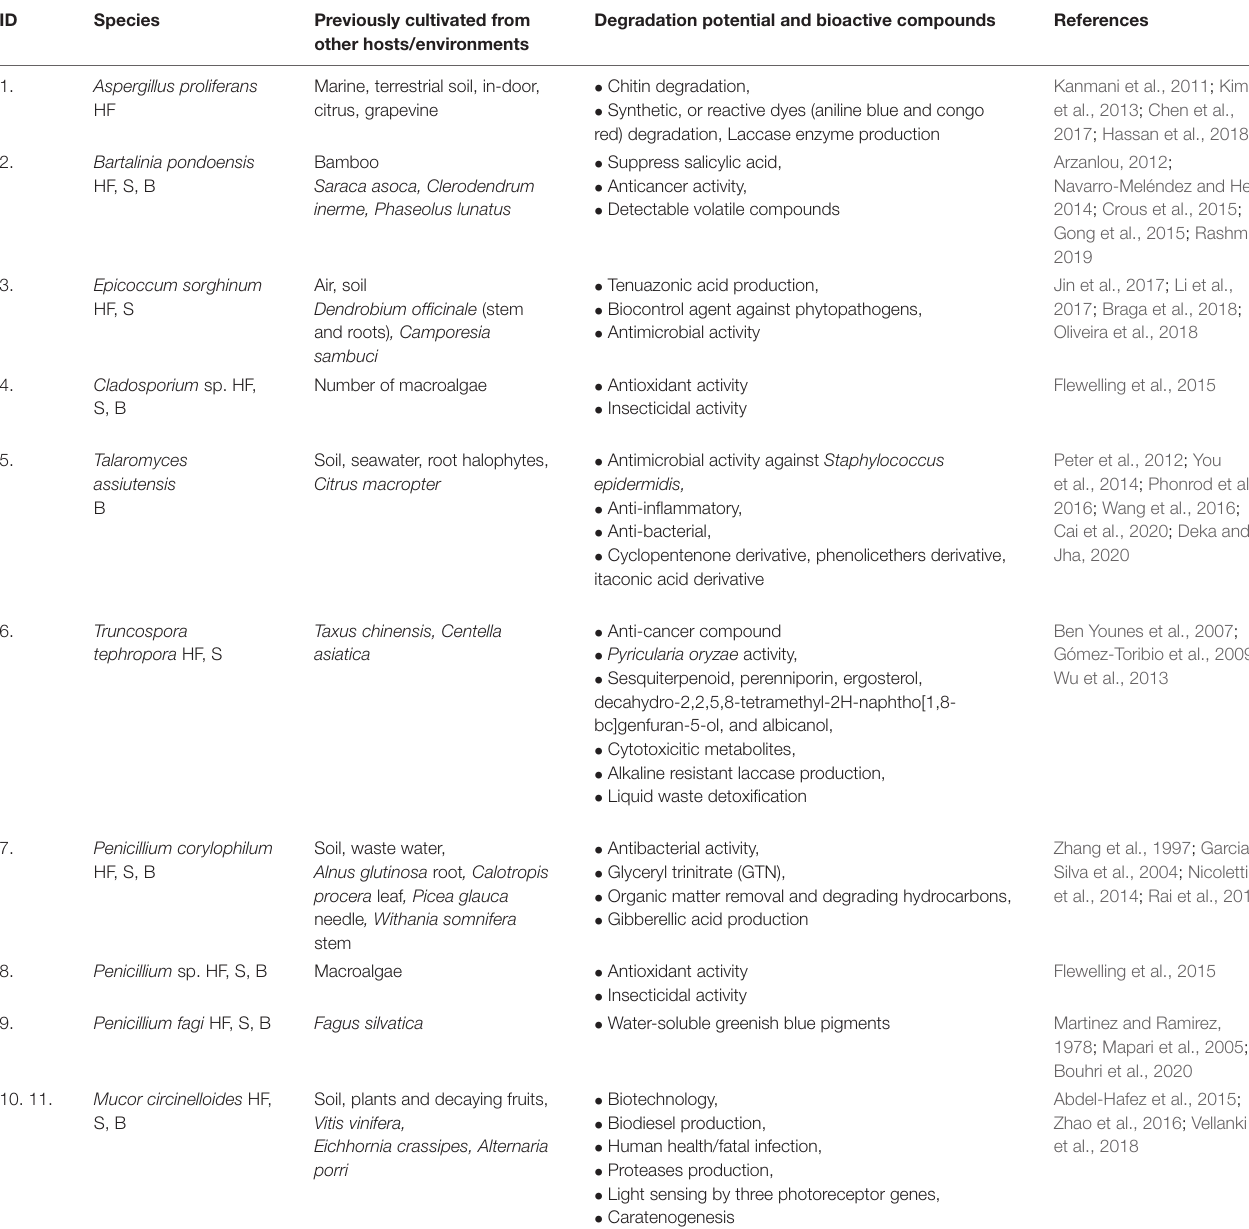
TABLE 1 | Isolated kelp endophytic fungi from E. radiata and their occurrence in different plant tissues (HF-holdfast, S-stipe, B-blade). ID Species Previously cultivated from other